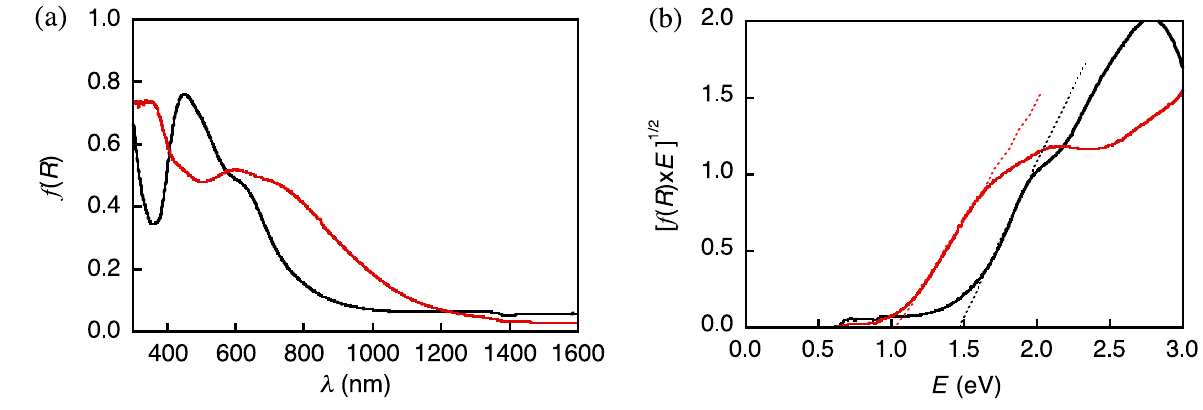
Figure 3. ( a ) Diffuse reflection spectra of Cu(Cy 2 dtc) 2 (black) and 1 (red); ( b ) Plot of the modified Kubelka-Munk function vs. energy of exciting light for Cu(Cy 2 dtc) 2 (black) and 1